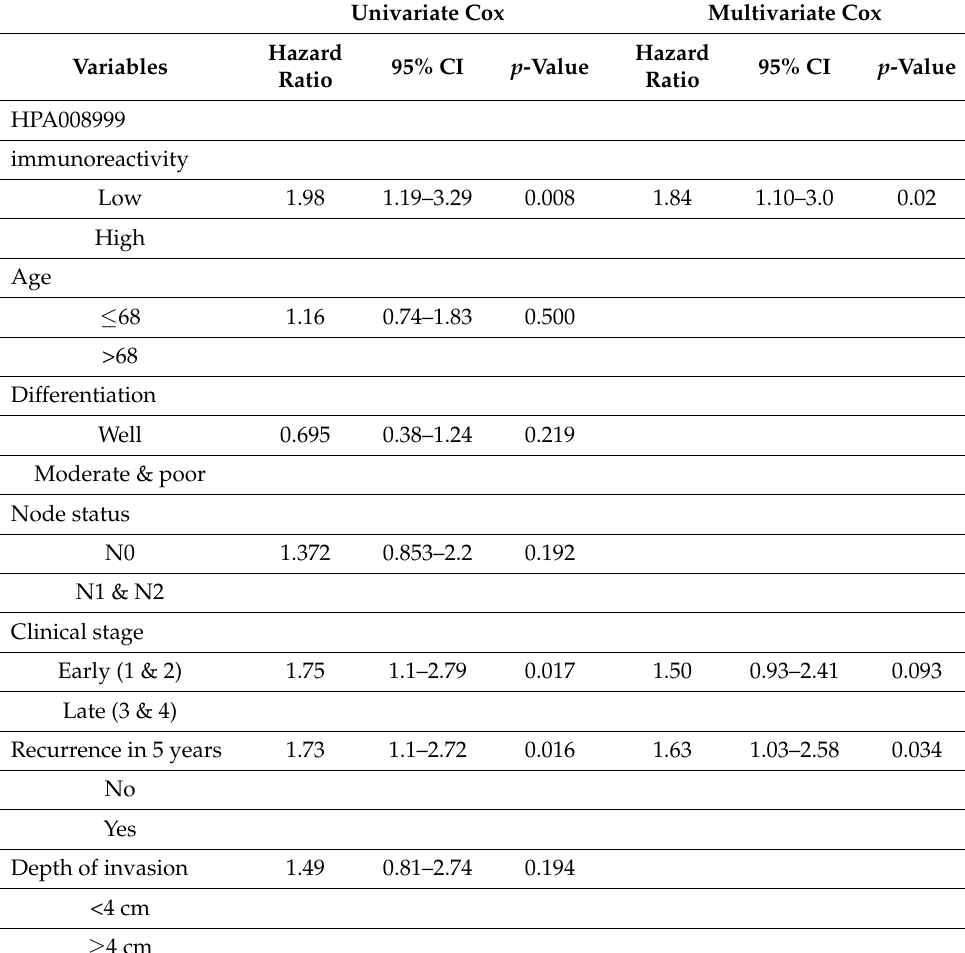
Table 2. Results of a multivariate Cox regression analysis for predicting the 5 year overall survival of OSCC